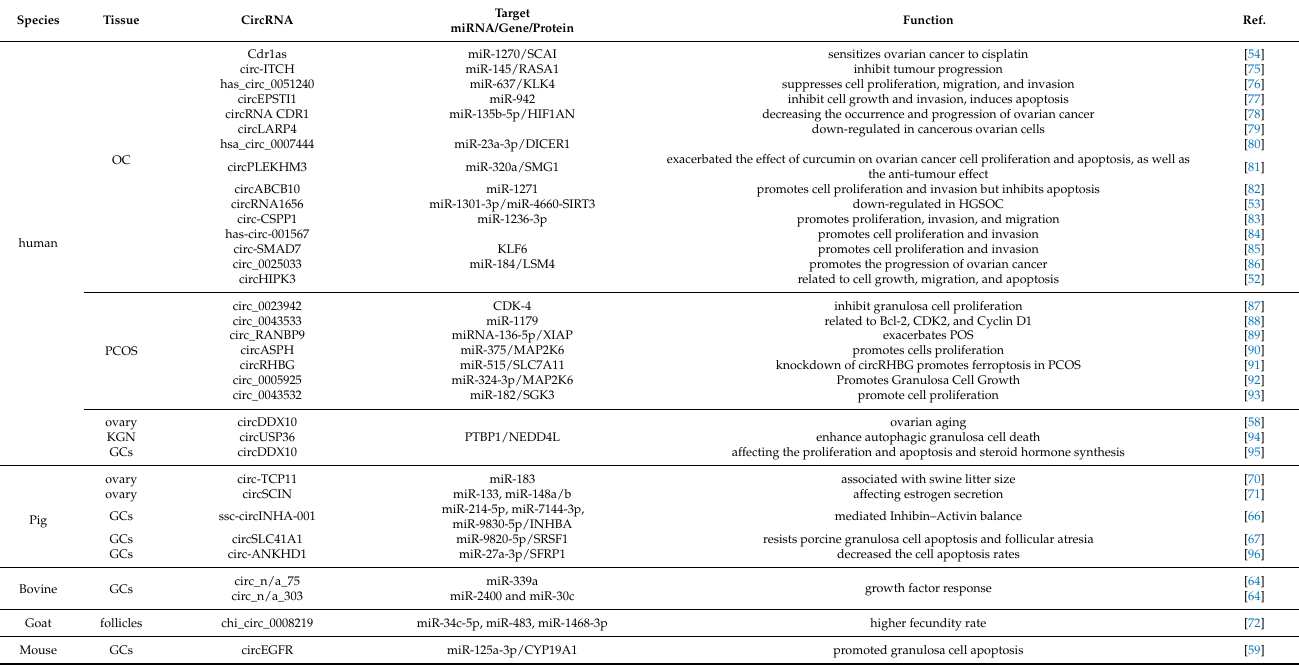
Table 1. Circular RNAs and their role in the different